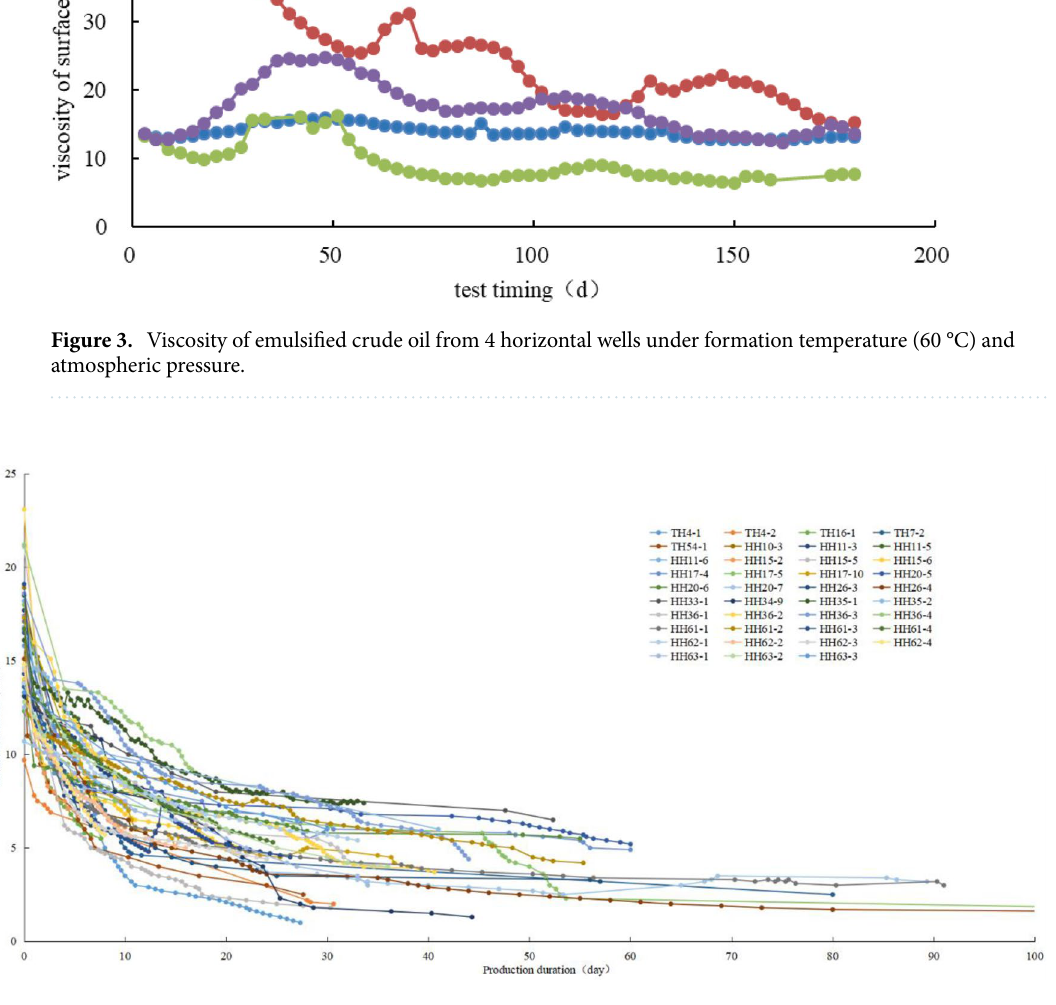
Figure 4. Wellhead pressure drop curve with time of horizontal well in interlayer shale oil